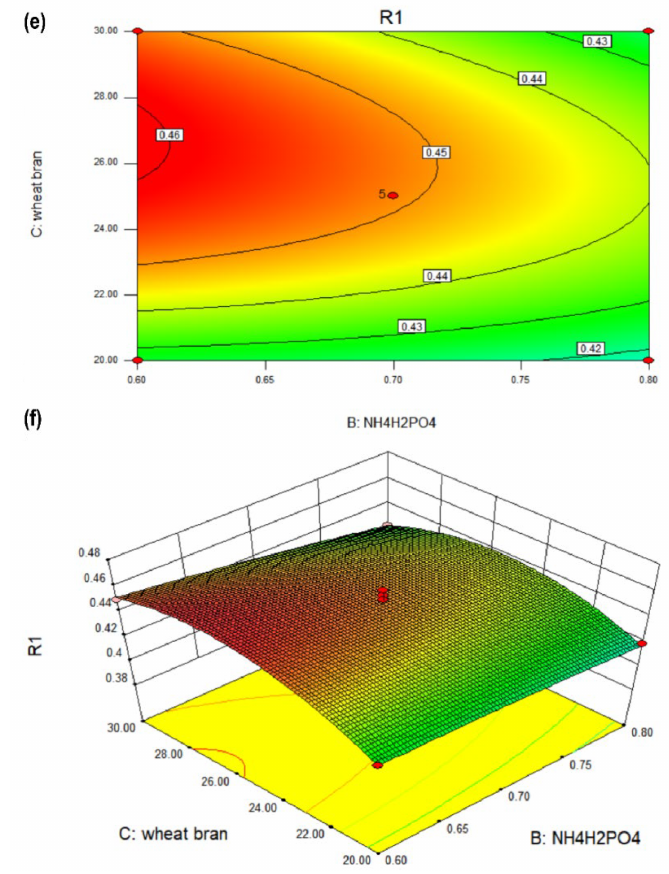
Figure 5. ( a , b ): sucrose × NH 4 H 2 PO 4 response surface plot and contour map; ( c , d ): sucrose × wheat bran response surface plot and contour map; ( e , f ): NH 4 H 2 PO 4 × wheat bran response surface plot and contour